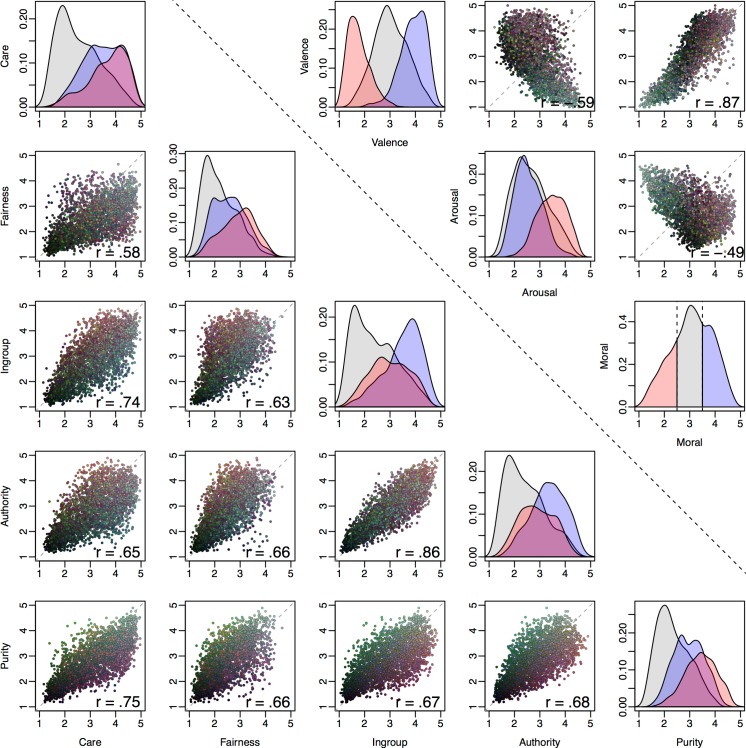
Correlations and rating distributions across images for (1) moral content dimensions (lower section below black dashed line), and (2) valence, arousal and morality (upper section above black dashed line).On diagonal: density plots of relevance ratings for each moral foundation (lower section), and valence, arousal and morality (upper section), with each plot divided into morally good (blue; mean moral rating > 3.5), bad (red; mean moral rating < 2.5), and neutral (grey; all other images). Off diagonal: scatterplots of average ratings for all images with Pearson correlation coefficients inset. To aid interpretation, point color represents moral content ratings collapsed into the CAD triad [140] with each of the three dimensions mapping onto a different color (Community [Ingroup + Authority] = red; Autonomy [Care + Fairness] = blue; Divinity [Purity] = green).